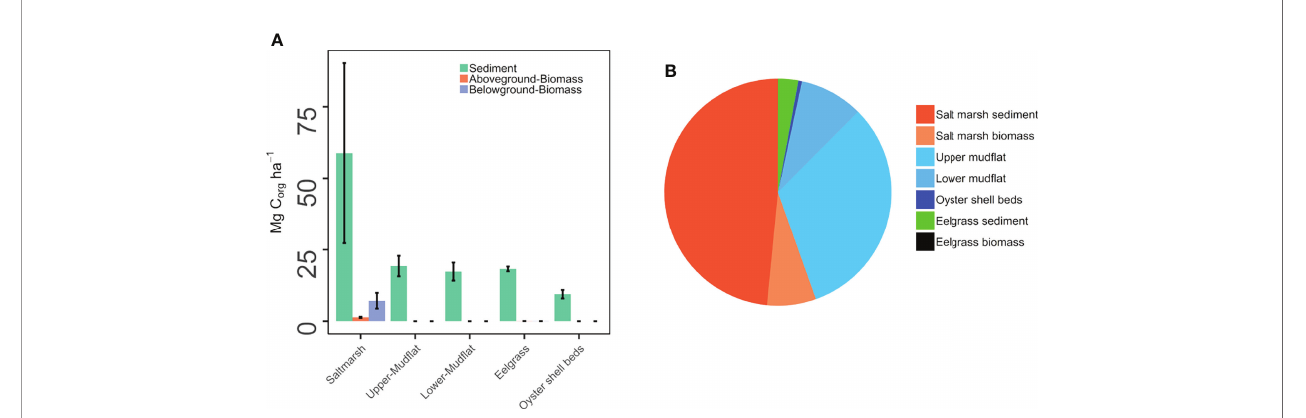
FIGURE 5 | Comparison of the total biomass and sediment organic carbon (OC) stocks in the salt marsh, upper mud fl at, lower mud fl at, eelgrass meadow, and oyster shell beds of the Cowichan Estuary. Panel (A) is per-hectare sediment and vegetation biomass organic carbon stocks; Panel (B) is total area-integrated sediment and vegetation biomass OC stocks. Bars represent standard errors.